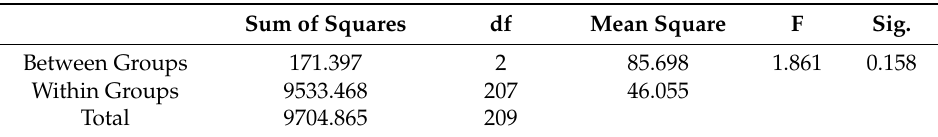
Table 2. One-way analysis of variance